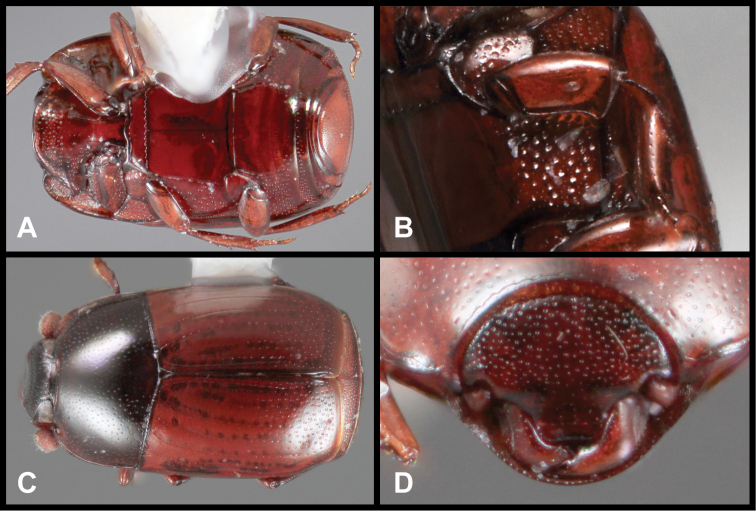
Baconia angusta group. A Ventral habitus of Baconia cavei
B Mesofemur and tibia of Baconia dentipes
C Dorsal habitus of Baconia rubripennis
D Frons of Baconia lunatifrons.